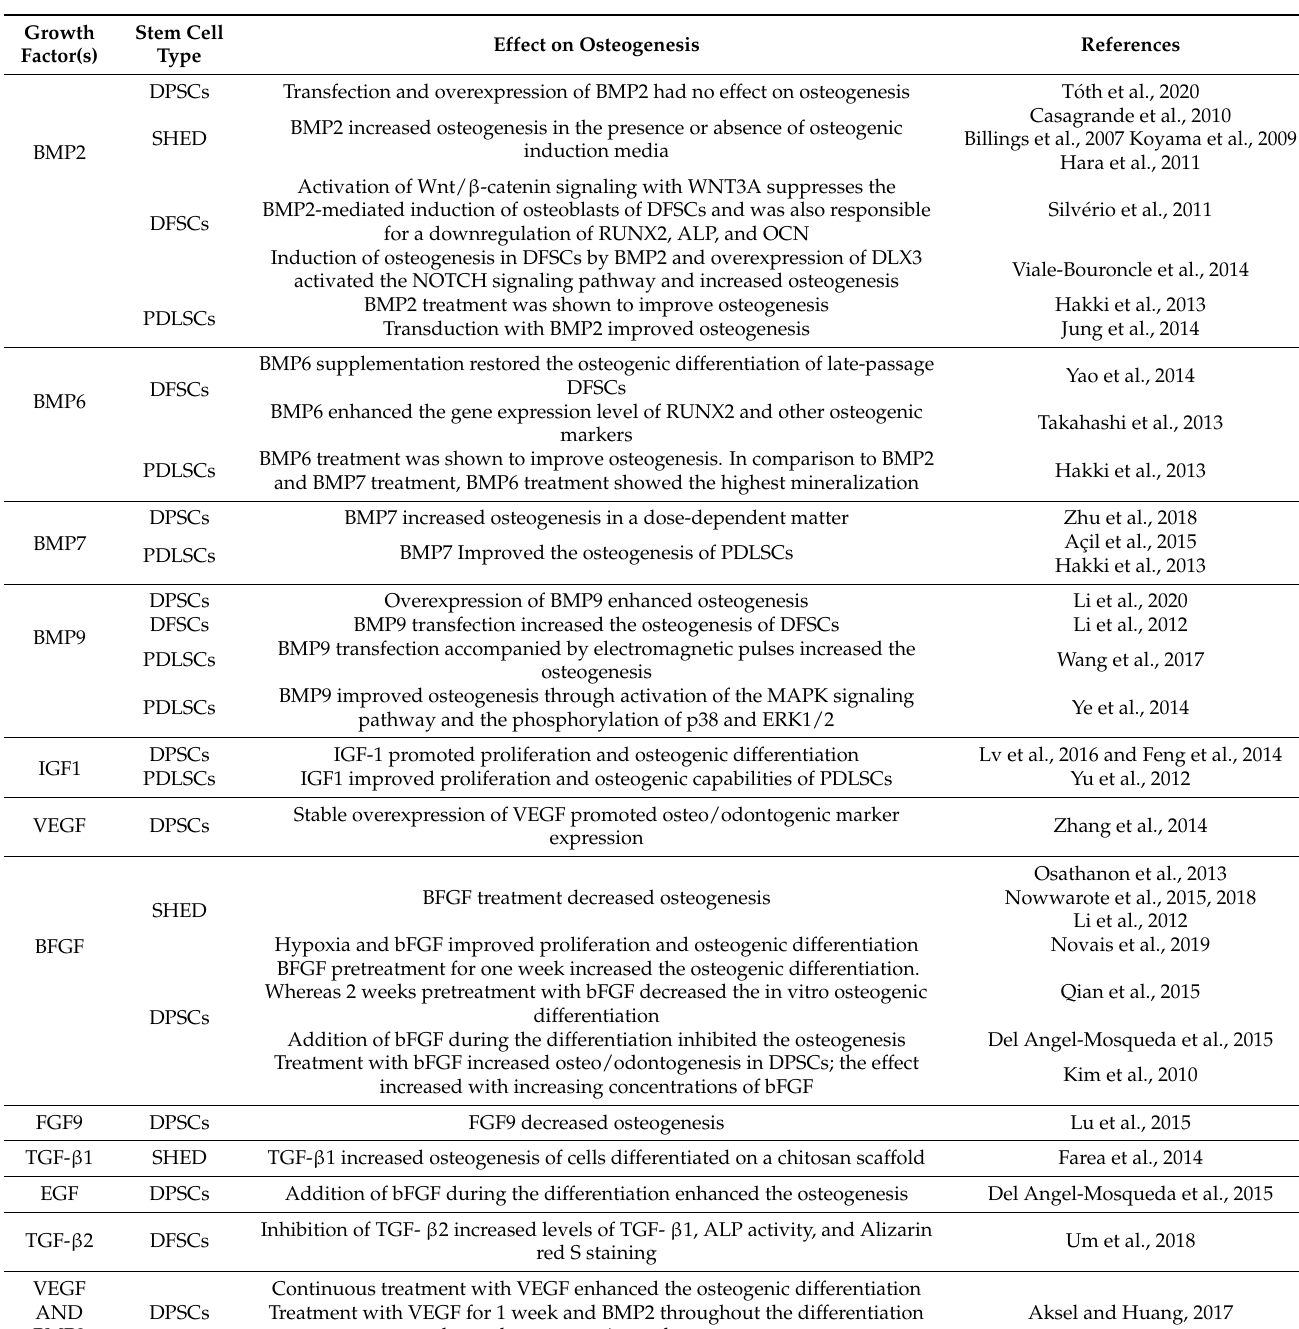
Table 1. A Summary of the growth factors reported in this section and their effect on the osteogenic differentiation of dental stem